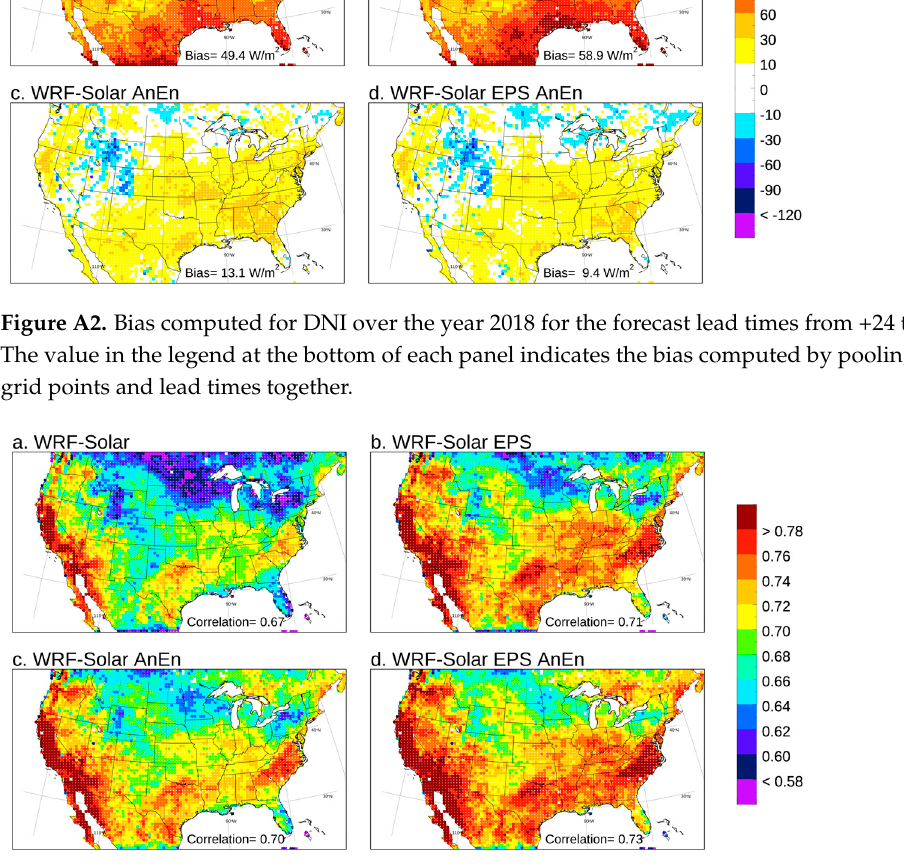
Figure A4. RMSE/spread ratio computed for all the grid points for DNI by pooling the forecast lead times from +24 to +48 h and forecast runs for 2018 together. Figure A5. Binned RMSE/spread diagrams are computed by pooling all the grid points for DNI forecasts, runs, and the forecast lead times from +24 to +48 h for 2018. The horizontal bars represent the 5–95% bootstrap confidence intervals of the spread for each considered bin.